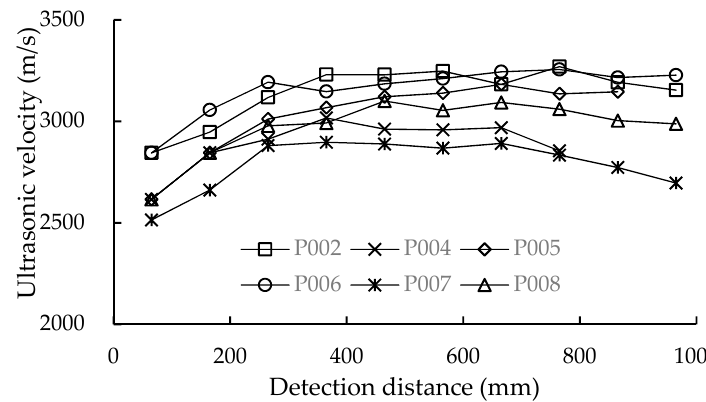
Figure 6. Relationship between detection distance and ultrasonic velocity.